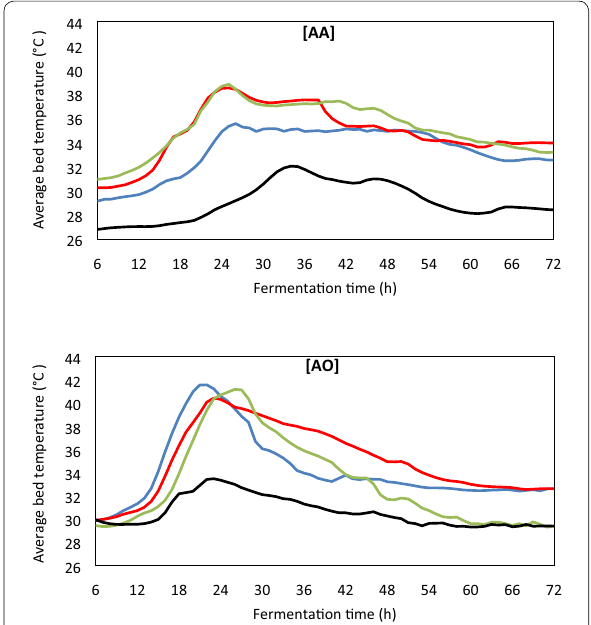
Fig. 7 Effect of the different initial moisture content arrangements on the heat evolution of A. awamori [AA] and A. oryzae [AO] grown on wheat bran performed in multi-stacked circular tray SSB. [blue line]— Exp 1; [red line]—Exp 2; [green line]—Exp 3 and [black line]—Exp